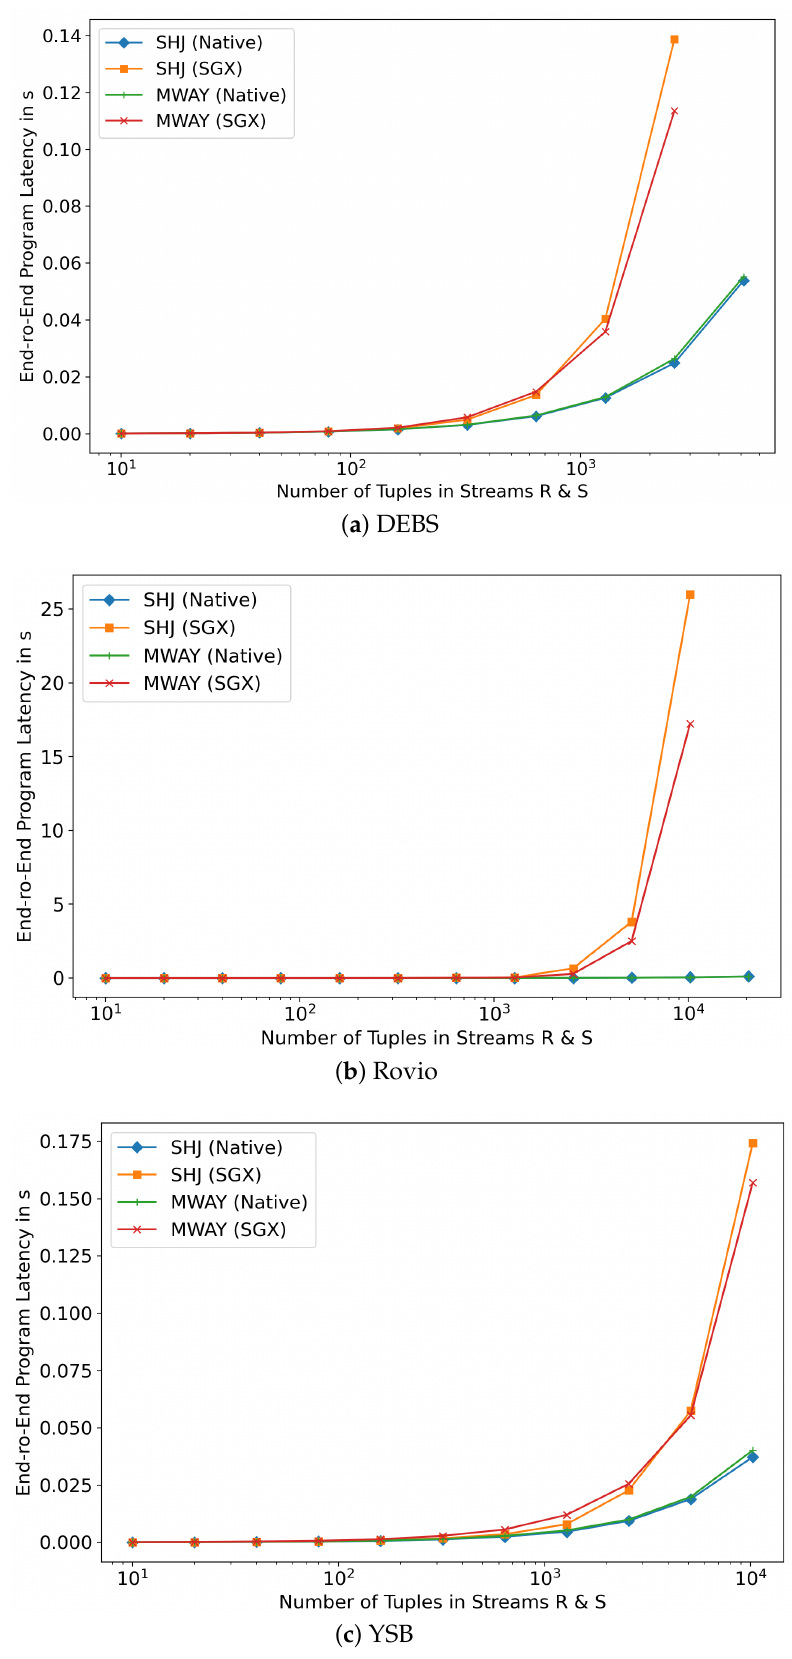
Figure 5. Average Latency with Different Processing